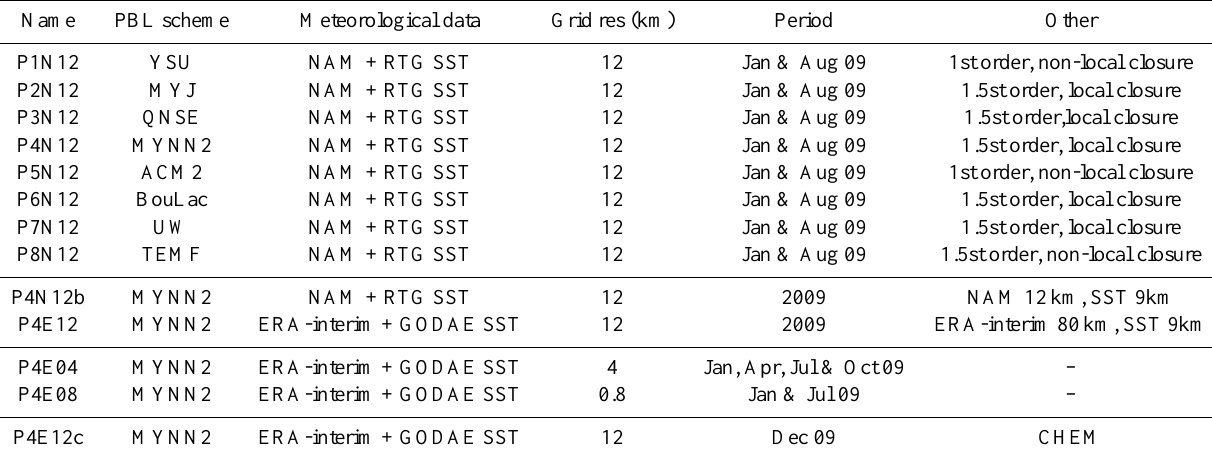
Table 1. Simulations. For each simulation, the first letter and number refer to the PBL scheme, the second letter refers to the initial and lateral boundary condition datasets (N for NAM and E for ERA-interim). The last 2 numbers are for the grid resolution (12 for 12km, 04 for 4km and 08 for 0.8km). The small letters b and c indicate respectively a longer simulation and a simulation with chemistry added in comparison to the code without the letter. For each simulation, the PBL scheme, the initial and lateral boundary condition datasets with their spatial resolution, the period of the simulation as well as additional comments are detailed.